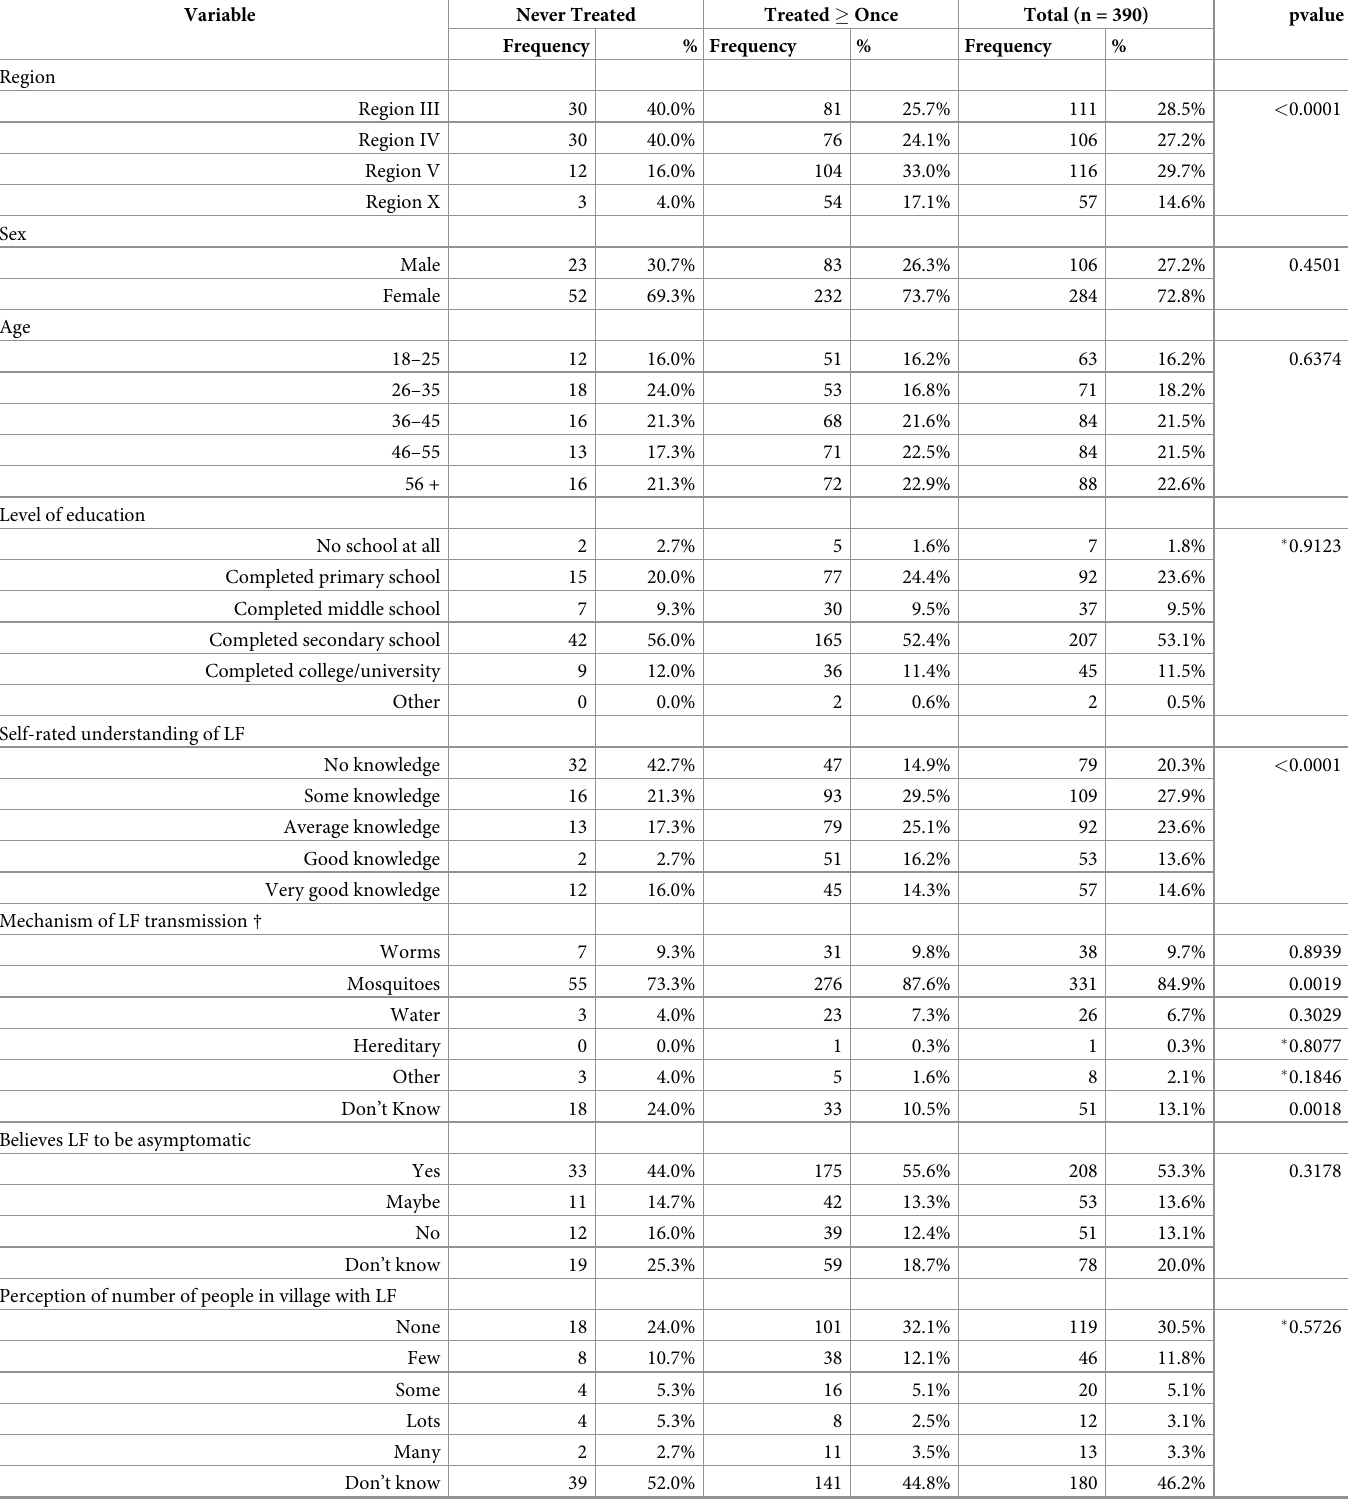
Table 5. Descriptive analysis of key demographic and knowledge variables across participants’ historical compliance with MDA in the primary study population.